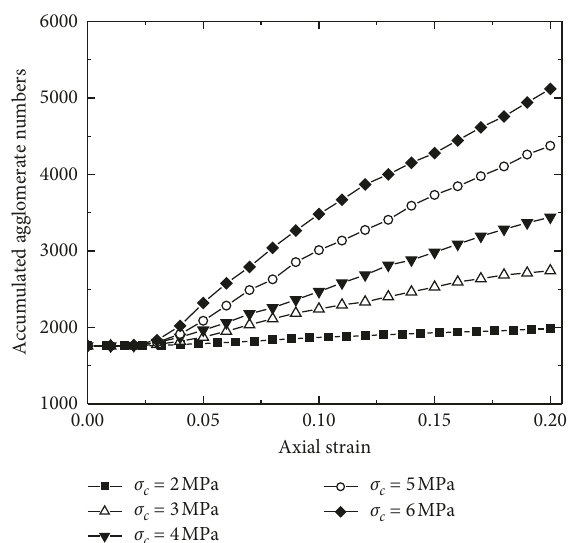
Figure 16: Evolution of the number of agglomerates.